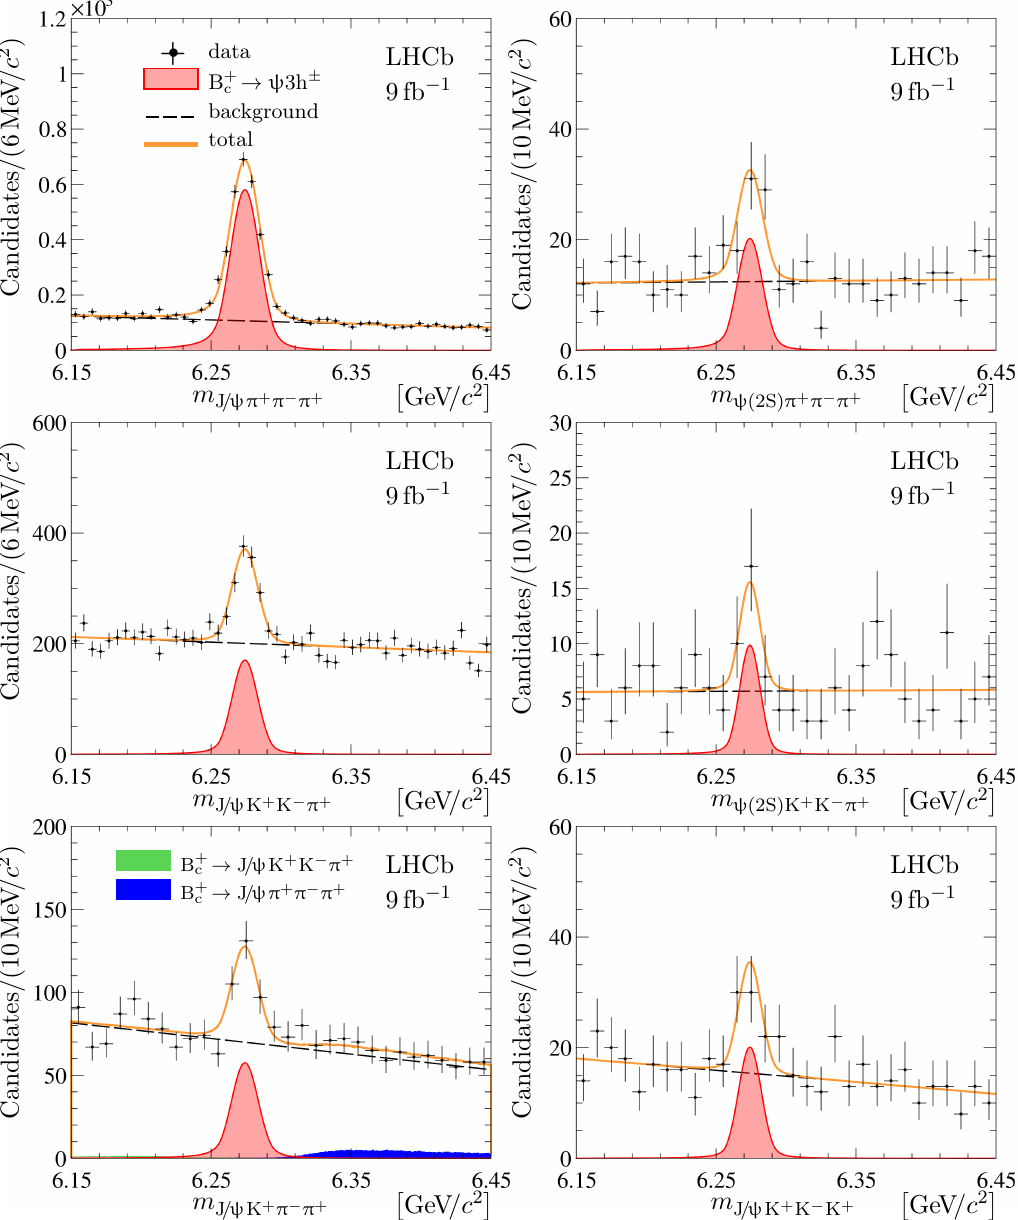
Figure 1 . Mass distributions for selected B + in the text, are